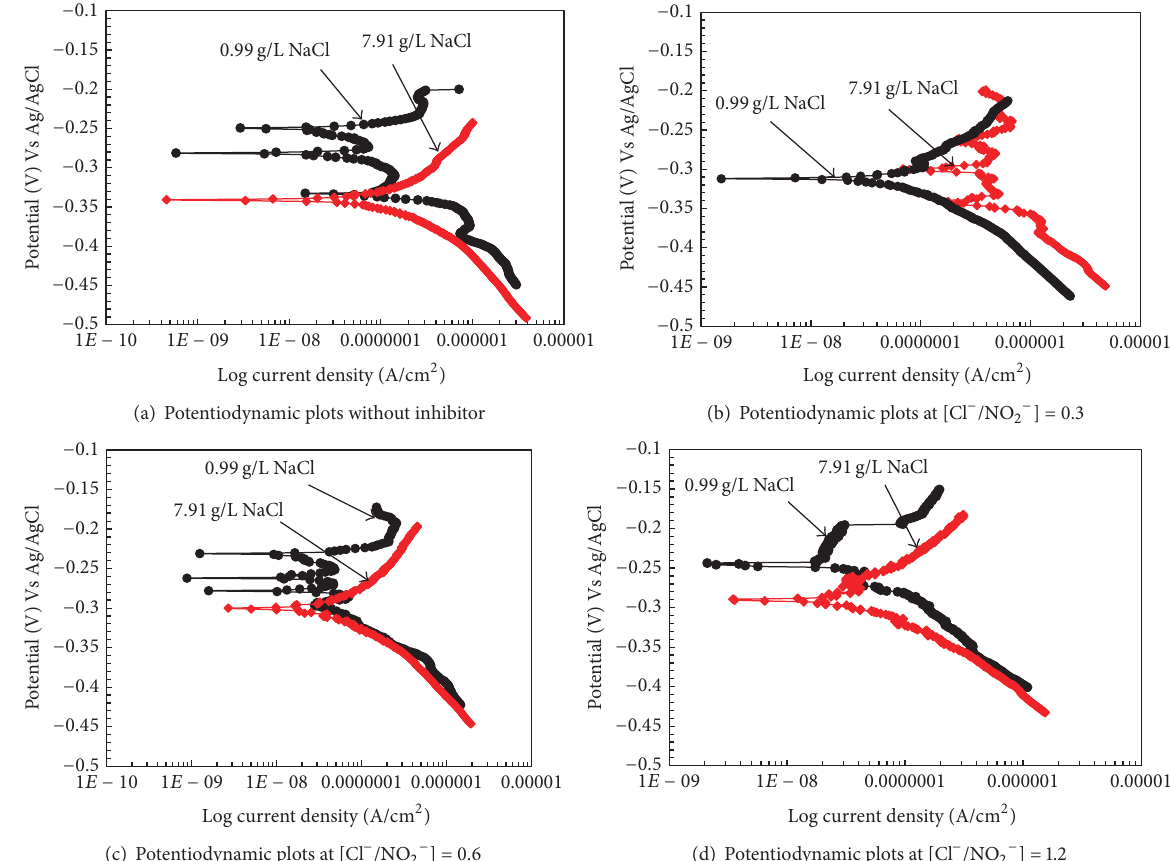
(c) Potentiodynamic plots at [Cl − / NO 2− ] = 0.6 (d) Potentiodynamic plots at [Cl − / NO 2− ] = 1.2 Figure 8: Potentiodynamic plots of steel rebar exposed in saturated Ca(OH) 2 solution with different concentrations of NaCl and [Cl − /NO 2−